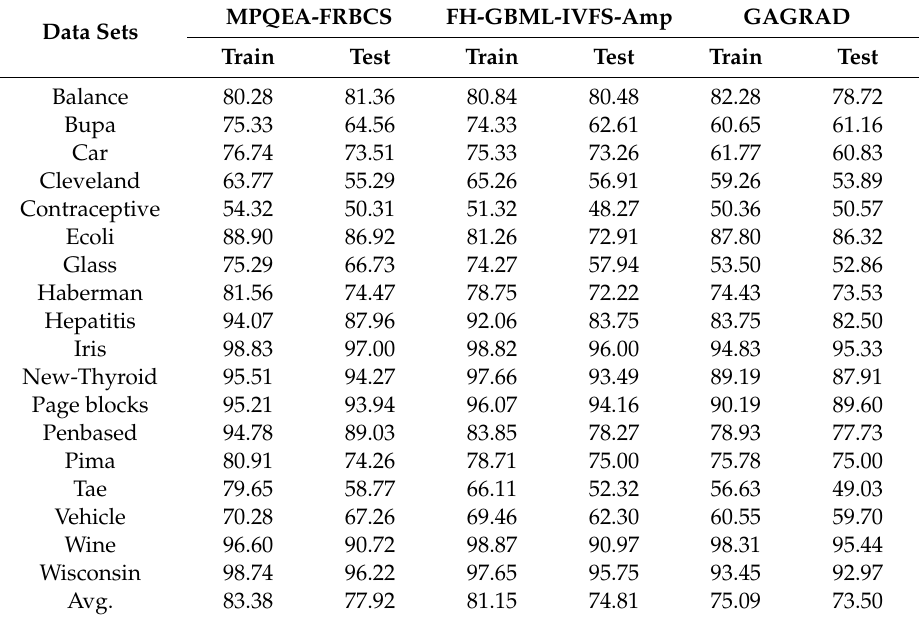
Table 6. Classification accuracy (in %) of the considered algorithms.